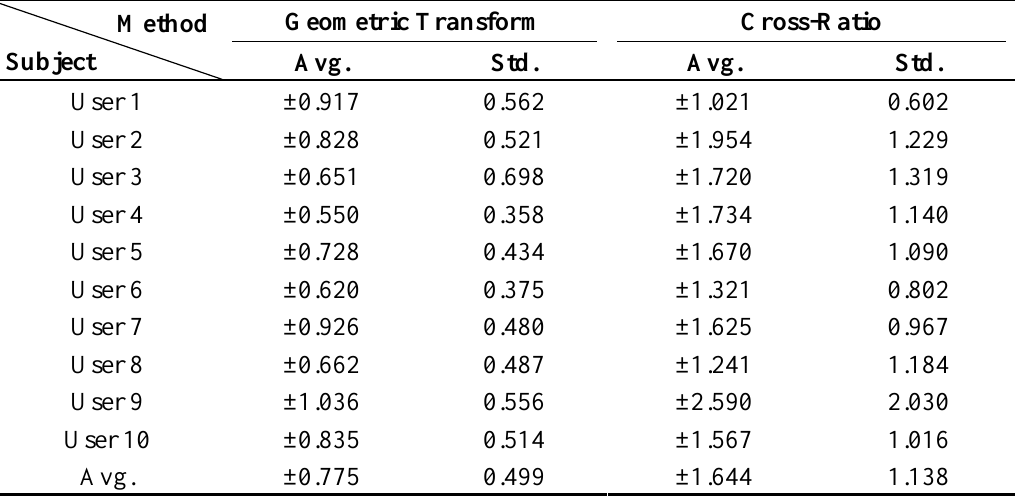
Table 3. Comparisons of gaze tracking error by our geometric transform-based method to that by cross-ratio based one in each subject—(1) (unit: degree).